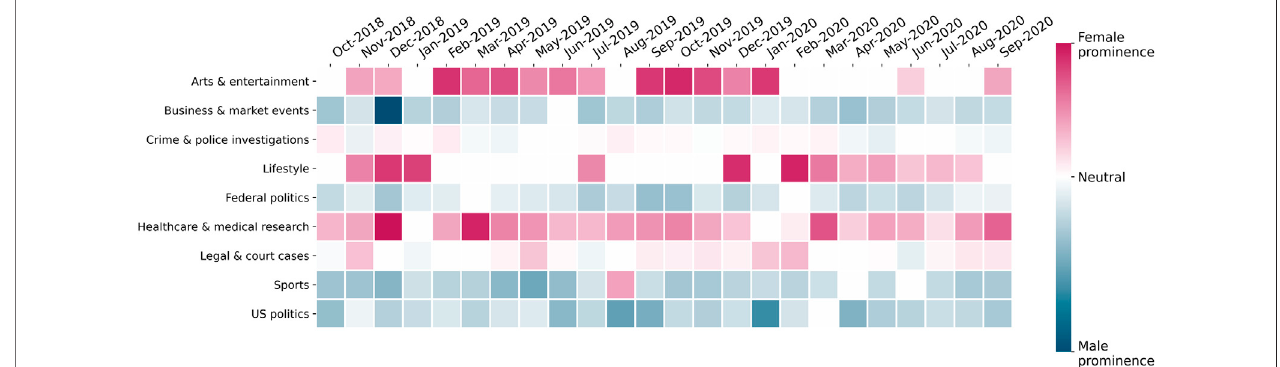
FIGURE 3 | Monthly topic gender prominence for nine recurring topics (average over all